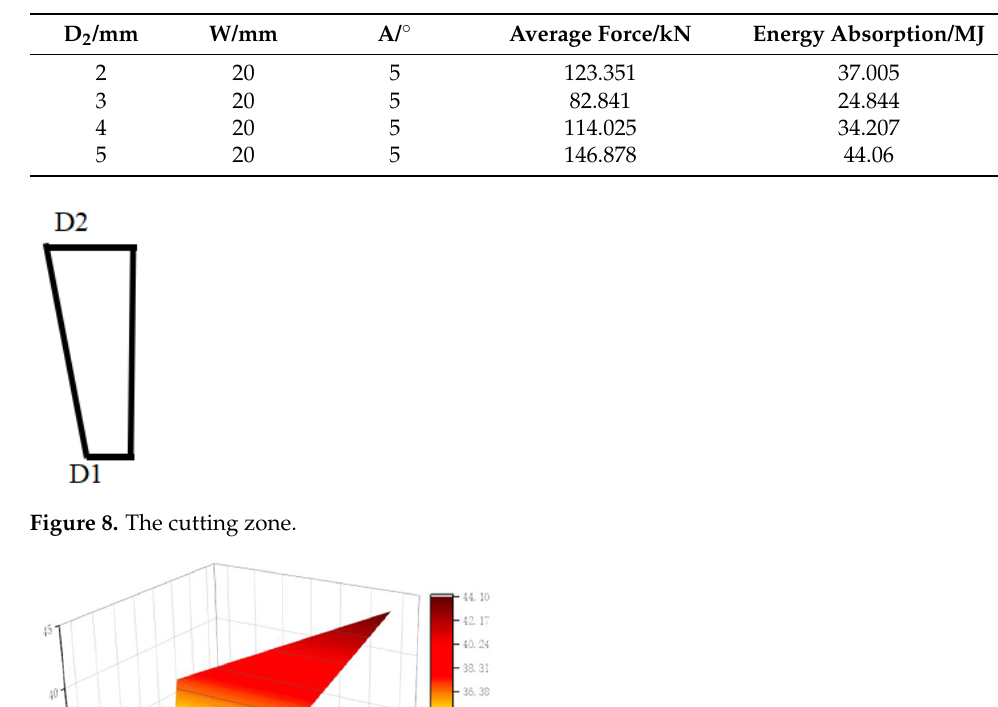
Table 3. Influence of D on material properties.